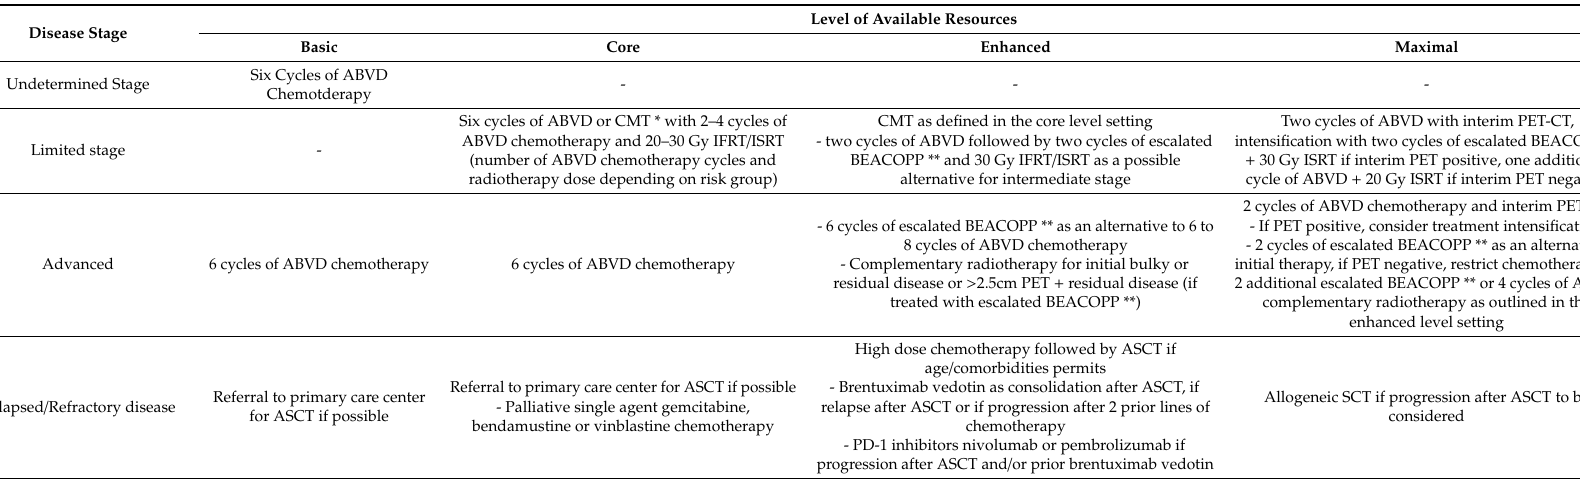
Table 2. Treatment recommendations according to available level of